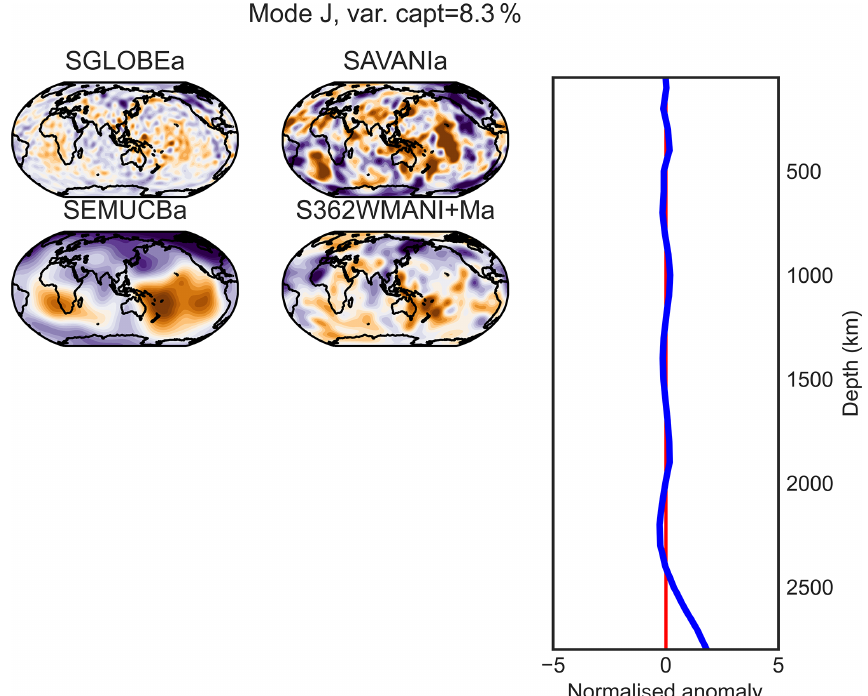
Figure E10. PC J (maximum at 2800km of depth) of the combined analysis of the anisotropic parts of the models.